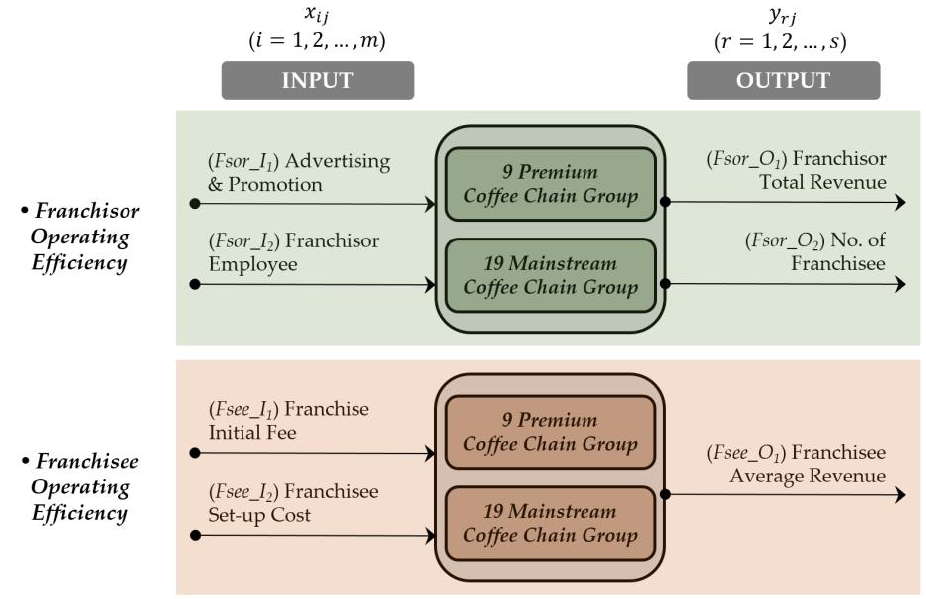
Figure 2. Research model for the metafrontier DEA on Koran coffee shop franchises.